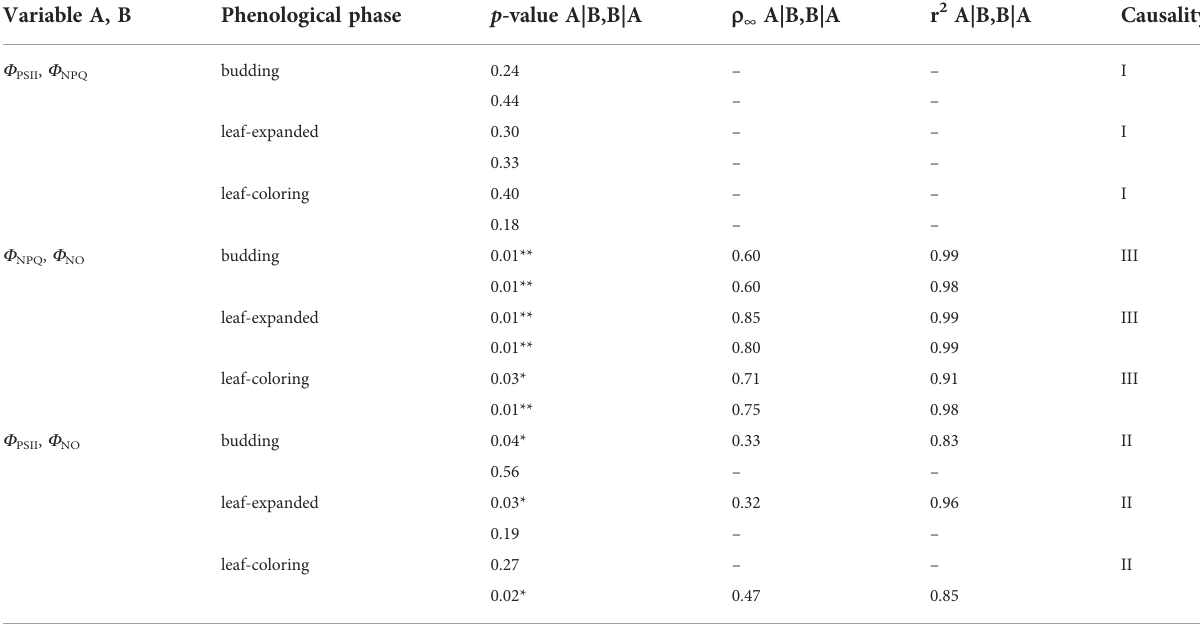
TABLE 4 Convergent cross mapping (CCM) with daily data pairs relating three PSII-energy partitioning pathways for different phenological phases from 2012 – 2017 ( L n ~ 202, 528, and 230 records); the number of bootstrapping iterations (n) = 1,000; and A|B and B|A stand for A forcing B and B forcing A,